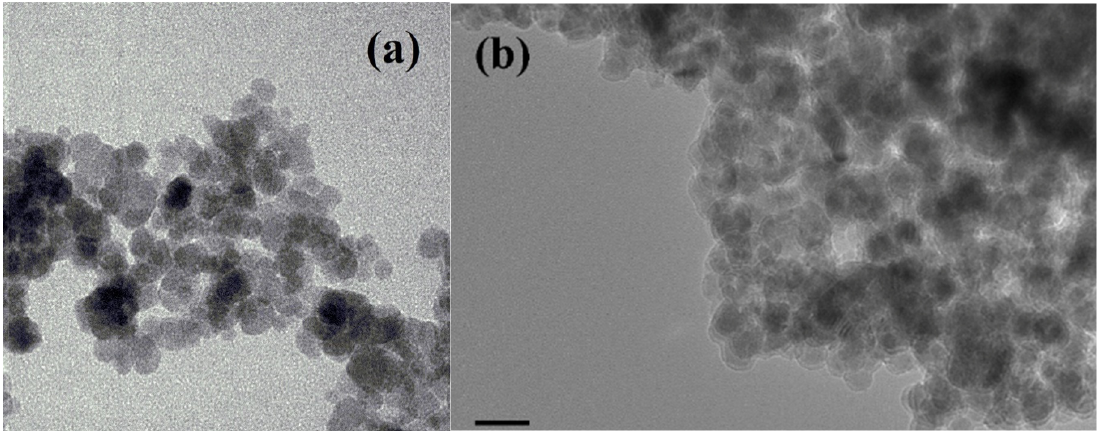
Figure 1. HR-TEM images of sample Fe 3 O 4 ( a ) and Fe 3 O 4 -SiO 2 ( b ).